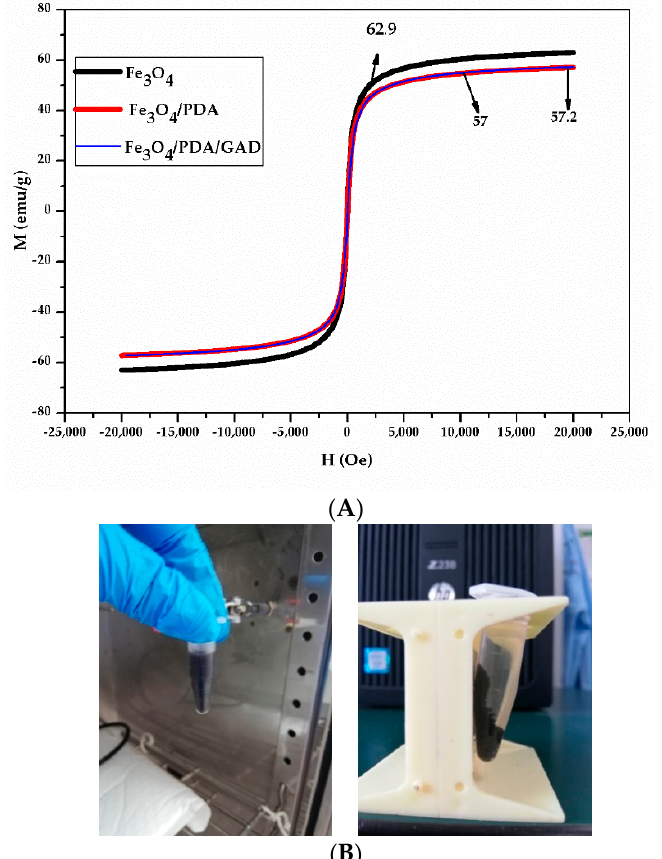
Figure 2. ( A ) Magnetization curve of Fe 3 O 4 , Fe 3 O 4 / PDA, and Fe 3 O 4 / PDA / GAD nanoparticles; ( B ) immobilized enzyme without and with an external magnetic field.